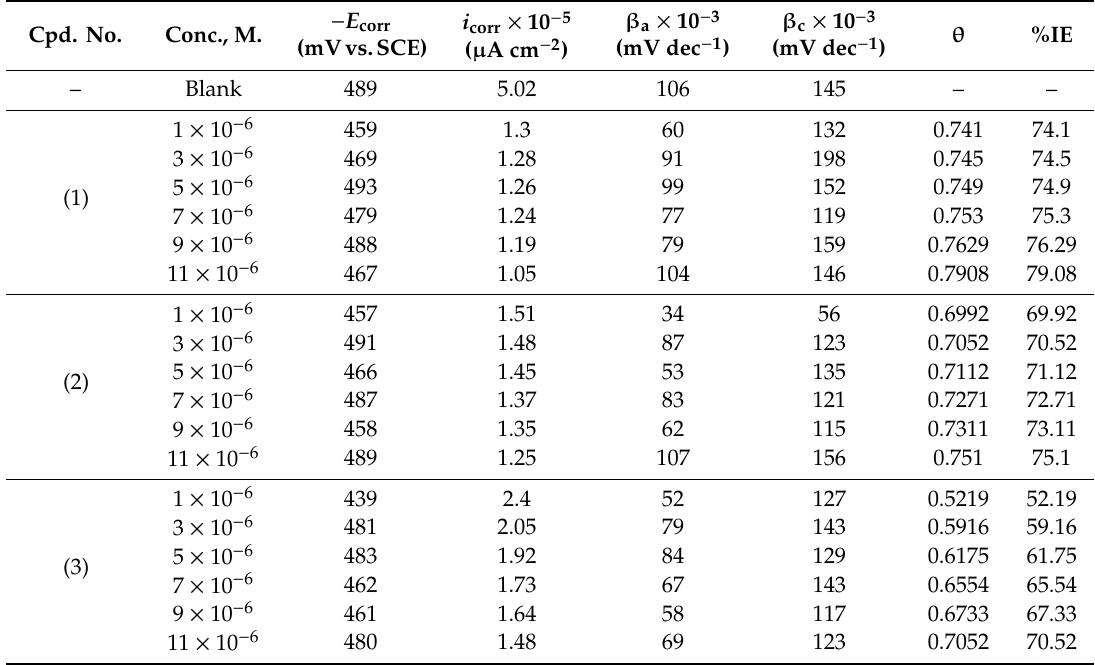
Table 2. Impact of spiropyrazoles derivatives for Q235 steel in in corrosive environments attendance and lack of unlike dose of spiropyrazoles. Cpd.